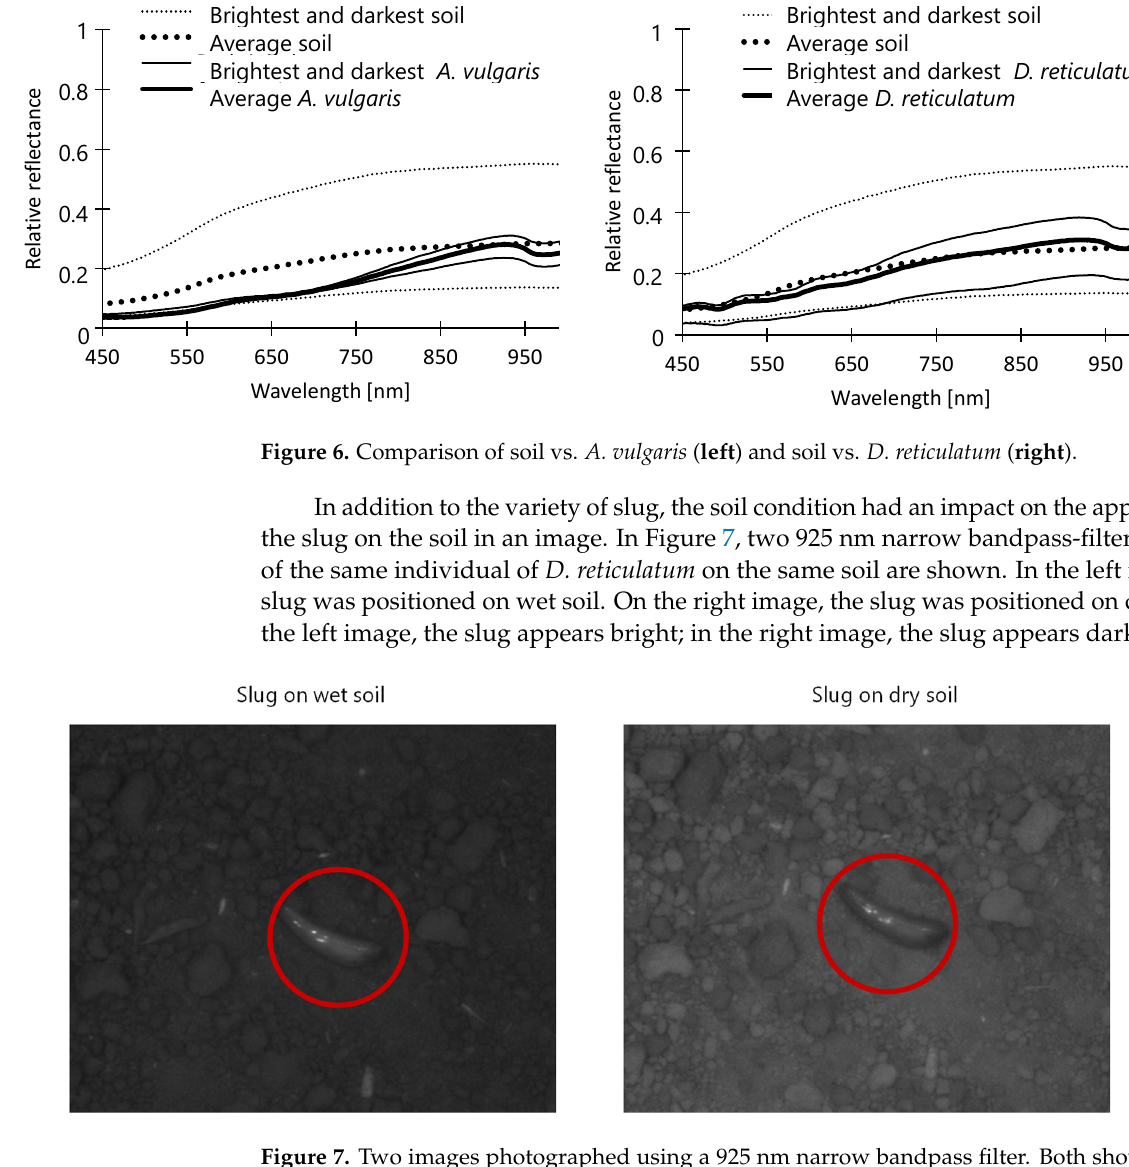
Figure 7. Two images photographed using a 925 nm narrow bandpass filter. Both show the same D. reticulatum individual on the same soil. On the left image, the soil is wet. On the right image, the soil is dry.